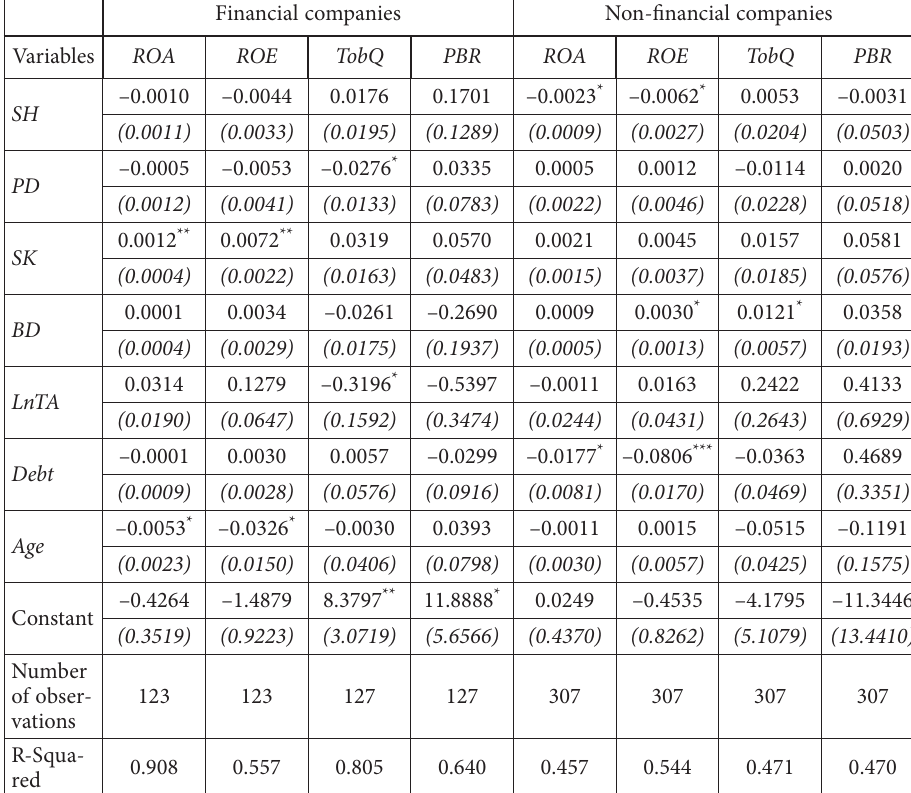
Table 6. Panel least-squares regression results with fixed effects Financial